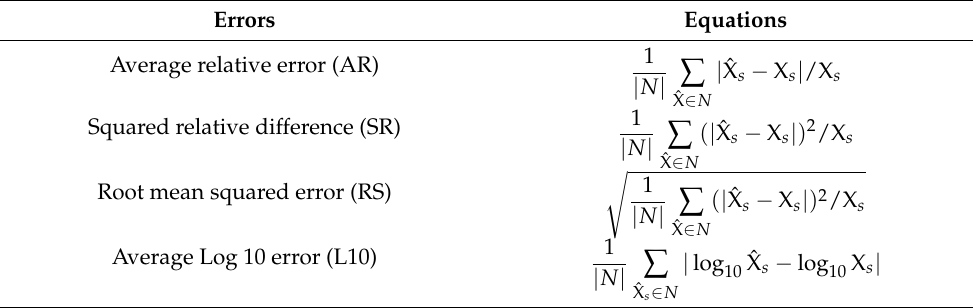
Table 2. Comparison of performances on UASOL and RADIATE datasets within 20 m.